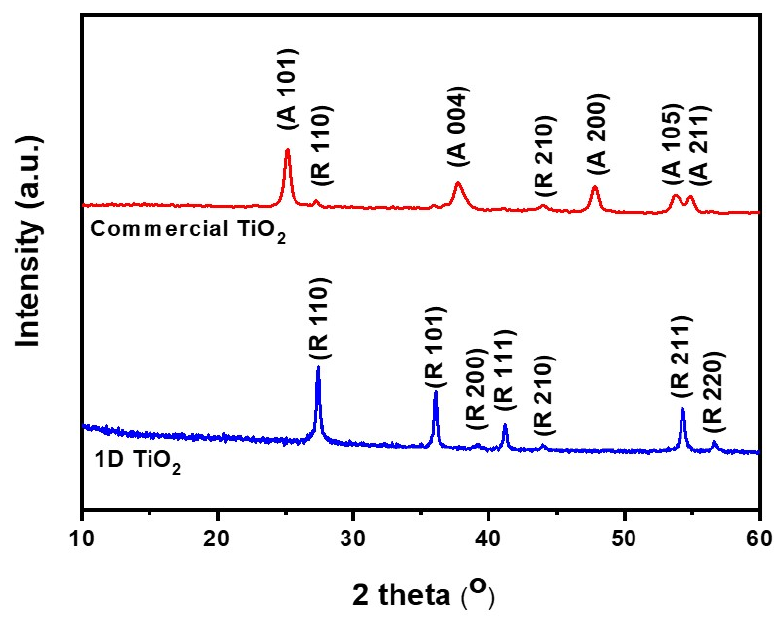
Figure 2. X-ray diffraction (XRD) patterns of 1D TiO 2 and commercial TiO 2 where R and A denote rutile and anatase phases, respectively.